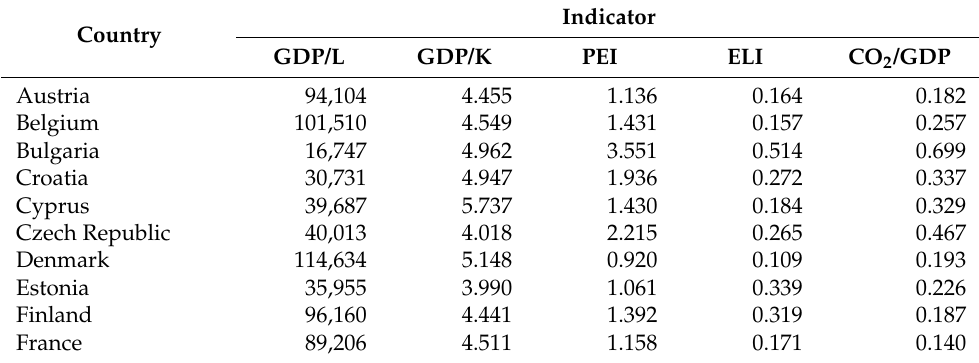
Table A5. Country means for the indicator variables over the entire